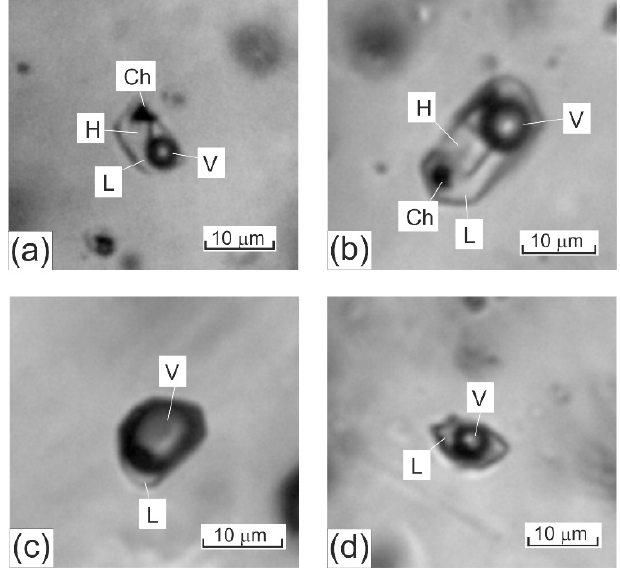
Figure 2. Three major types of fluid inclusions typically hosted in quartz from mineralized veinlets at porphyry deposits: ( a,b ) fluid inclusions of high-temperature chloride brines (the photos show dark gas bubbles, transparent cubic NaCl crystals, opaque chalcopyrite crystals, and solution); ( c ) gas fluid inclusions (the photos show a gas phase and a pale rim of aqueous solution; ( d ) two-phase gas–liquid inclusions of aqueous solutions of intermediate salinity (the photos show a roundish gas phase and pale aqueous salt solution). The scale bars are 10 µm. L–aqueous solution, V–gas phase, H–halite, Ch–chalcopyrite.